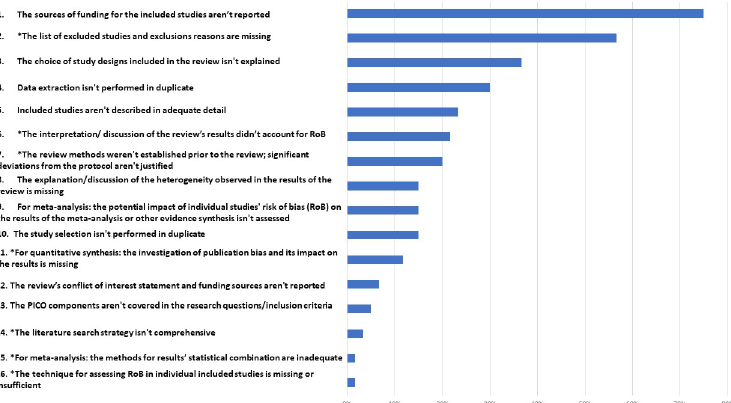
Fig 3. Included reviews’ methodological weaknesses identified according to the AMSTAR2 checklist [51]. ( � ) Items identified as critical in the AMSTAR2 tool checklist.